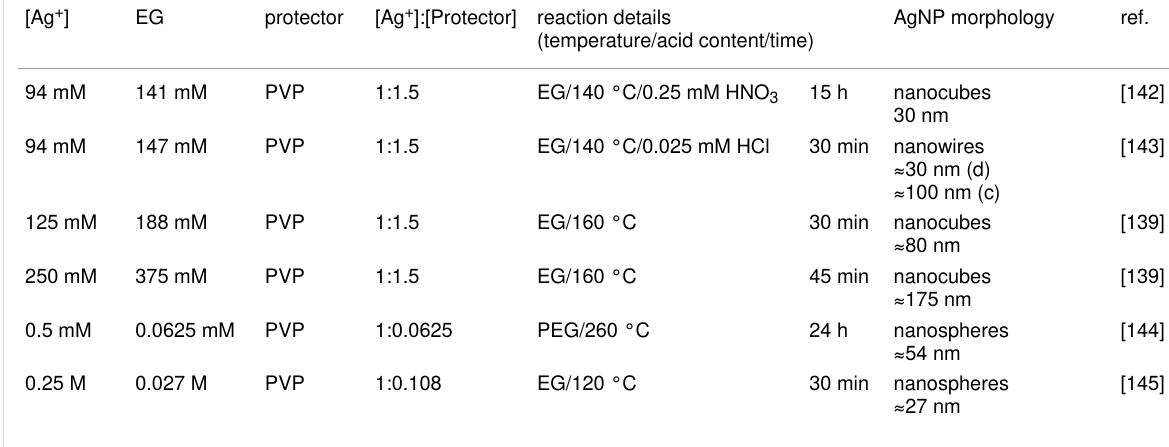
Table 3: Examples of the polyol process to obtain AgNPs with various